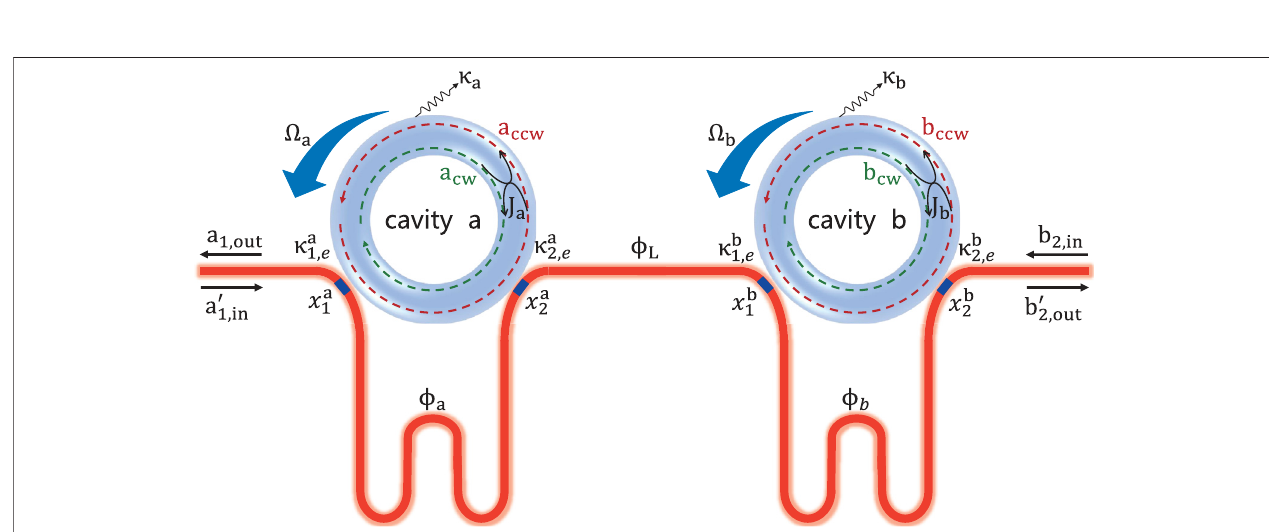
FIGURE3| (Coloronline)Transmissionrate T R versusdetuning Δ c / κ andphase θ c /2 π fordifferentcouplingstengths: (A) J =0,and (B) J =5 κ e .Pro fi lesof T R and T L versus Δ c / κ with θ c = 0.95 × 2 π : (C) J = 0 and (D) J = 5 κ e . Other parameters are set as: κ e = 5 × 10 − 3 ω c , Ω = 0.97 GHz, and κ c = 2 κ e .